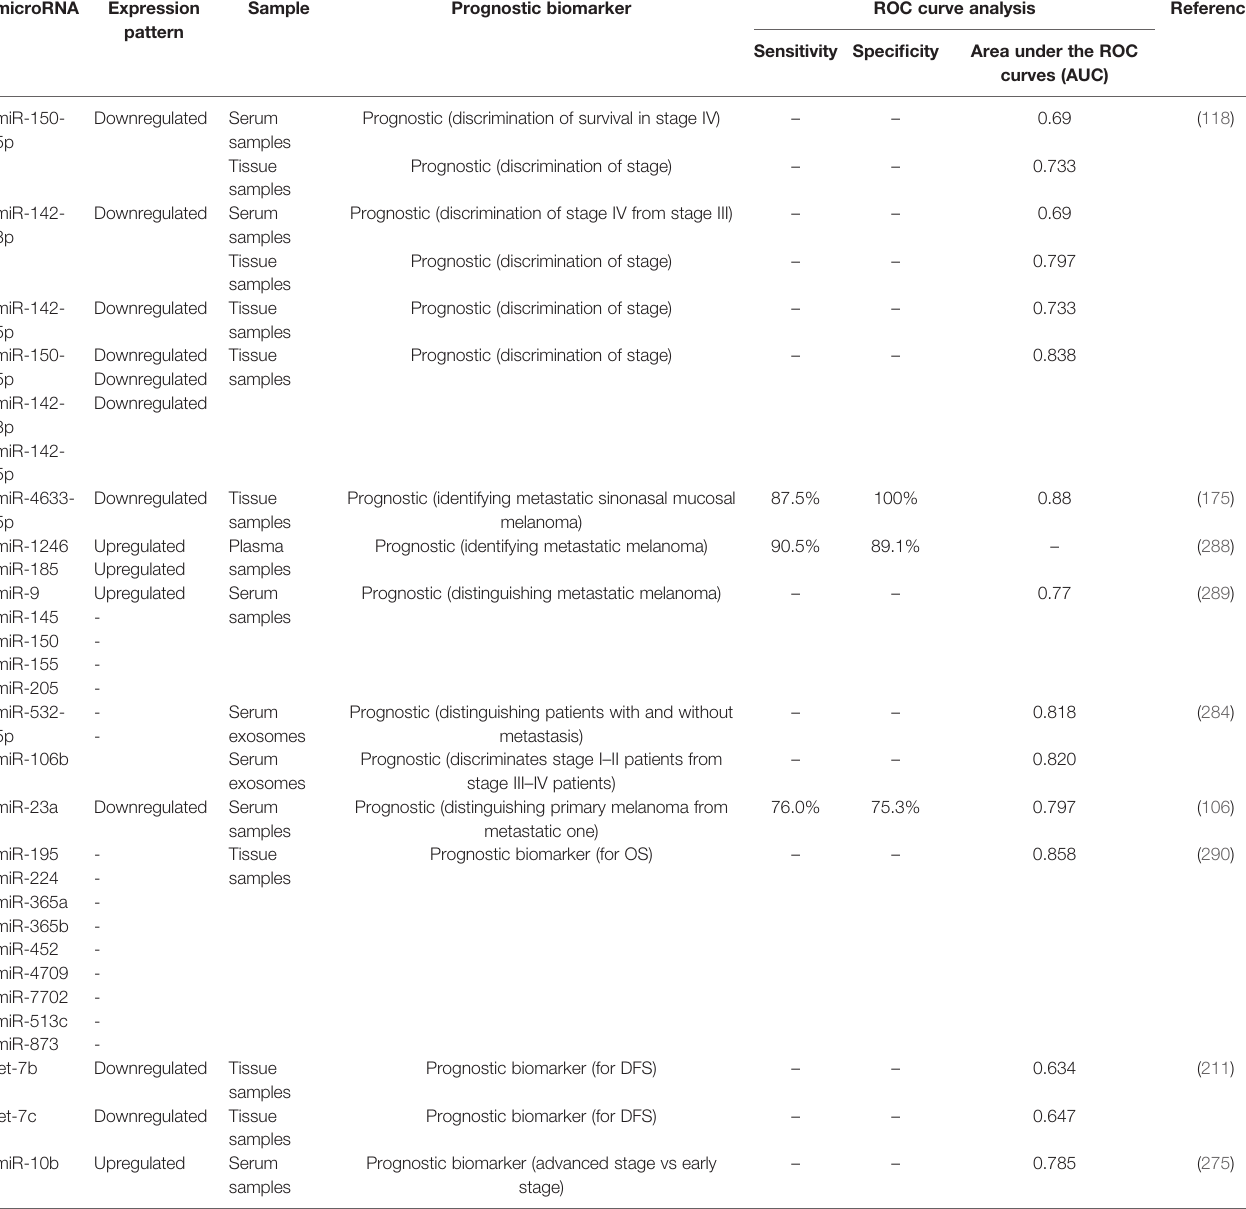
TABLE 5 | Prognostic role of miRNAs in melanoma as identi fi ed by ROC curve analysis.